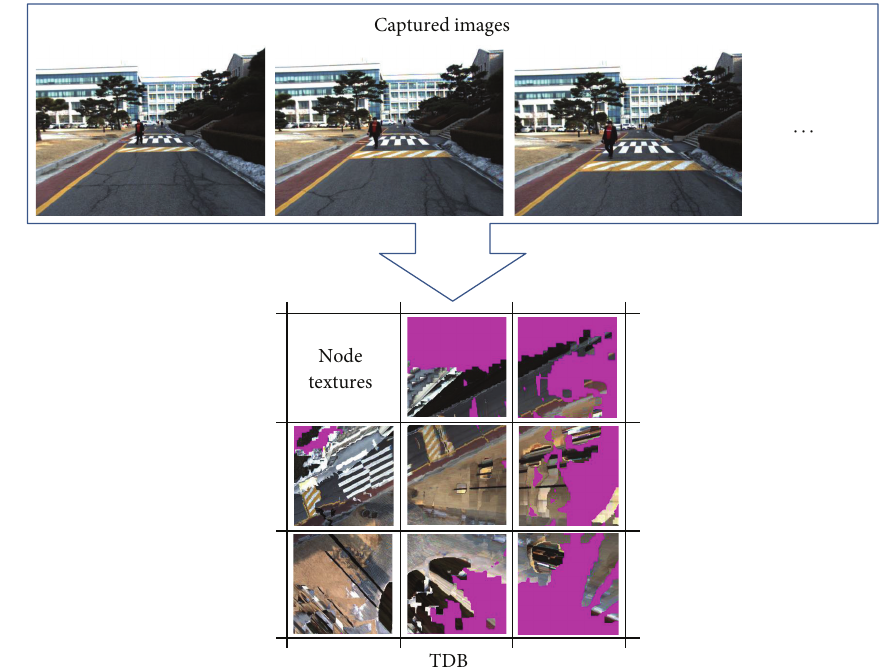
Figure 4: TDB generation from captured